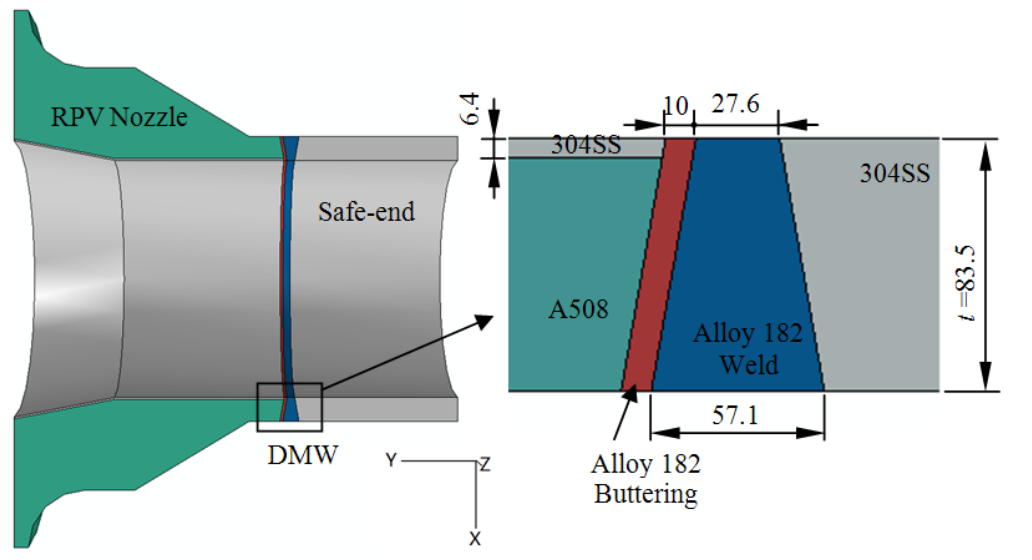
Figure 1: Geometry and material configuration of a DMW